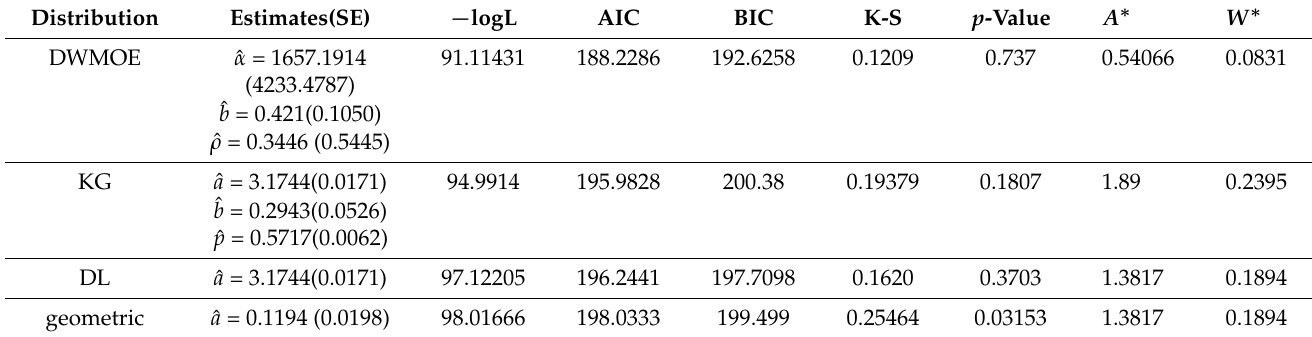
Table 5. Estimated values, − logL, AIC, BIC, K-S statistics, p -value, A ∗ and W ∗ for data set 1. Distribution